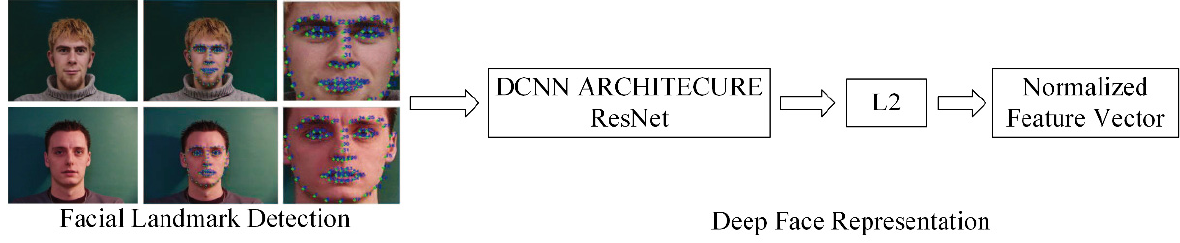
Figure 2. The diagram of the deep face representation. First, we determine the 68 landmark points of the face and crop them according to the landmark points. Then, we input the image and landmark points into the ResNet model, Finally, we use L2-normalization to obtain the normalized feature vector.